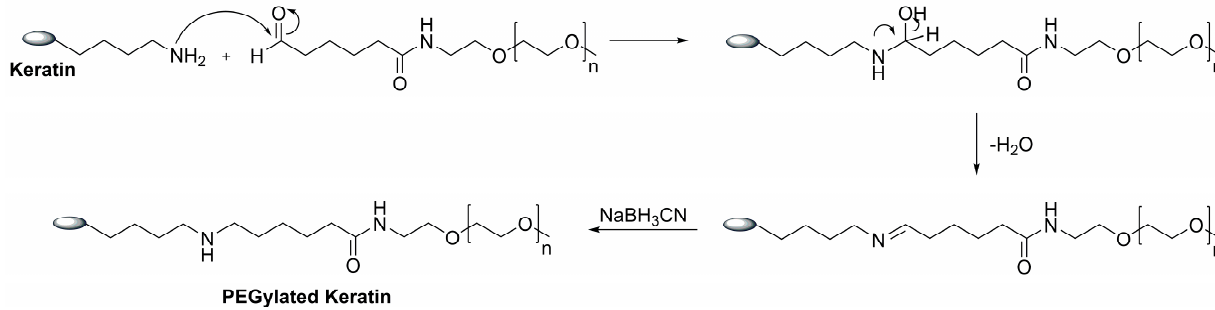
Figure 1. Reactional scheme of keratin PEGylation.